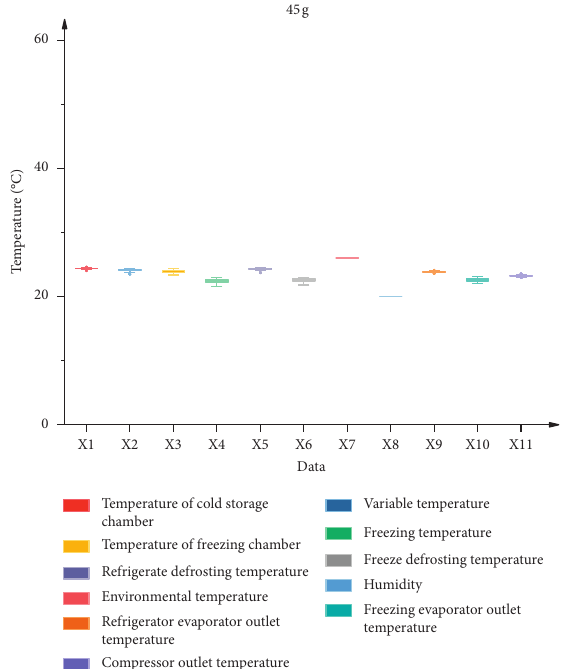
Figure 6: Exception data (refrigerant amount,